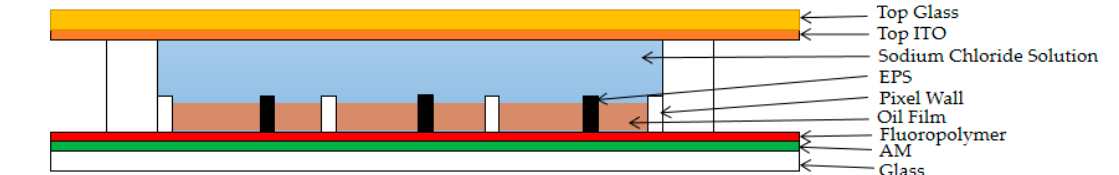
Figure 1. Electrowetting display (EWD) structure.